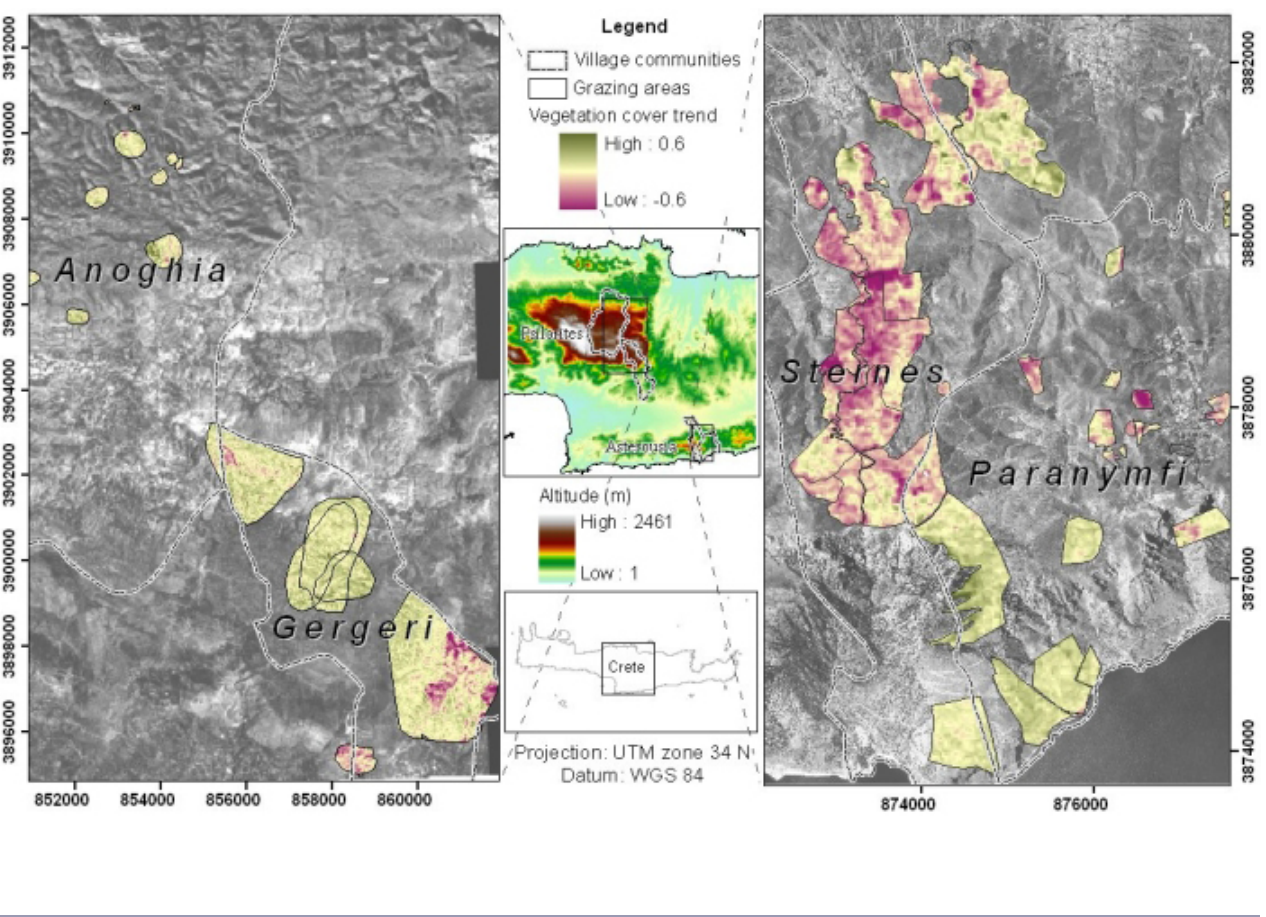
Figure 1. Studied village communities, household grazing areas and pixel-based vegetation-cover